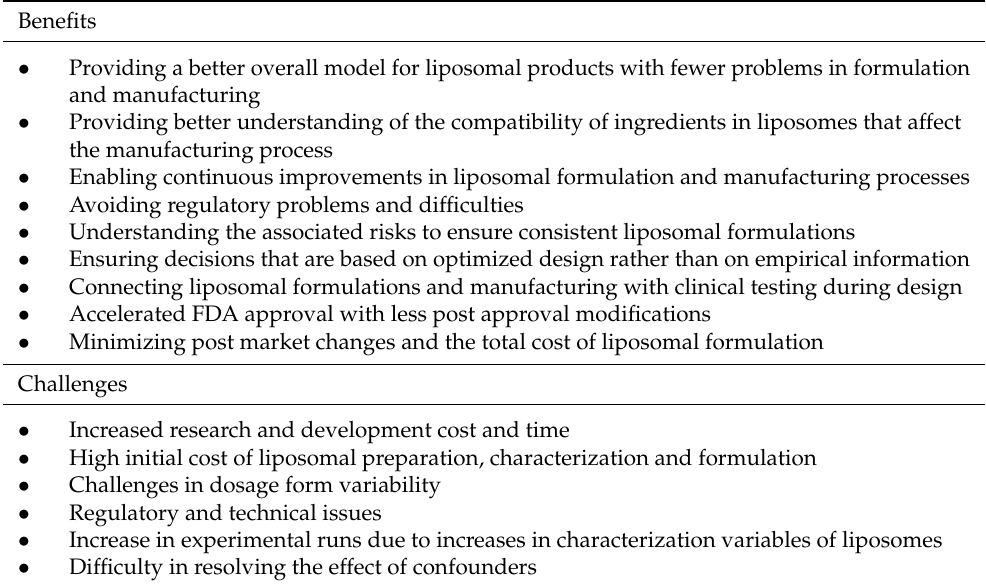
Table 2. Benefit and challenges of applying QbD in of liposomal-based